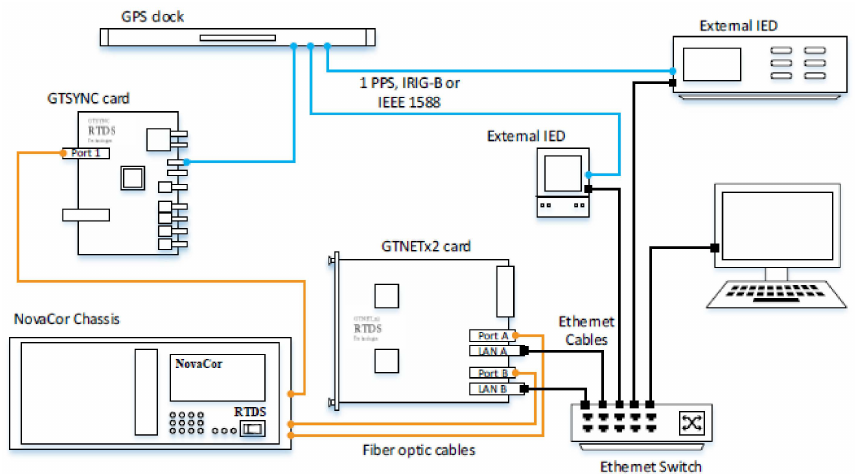
Figure 4. Connections between the real-time simulator and external equipment via the GTNETx2 card for network